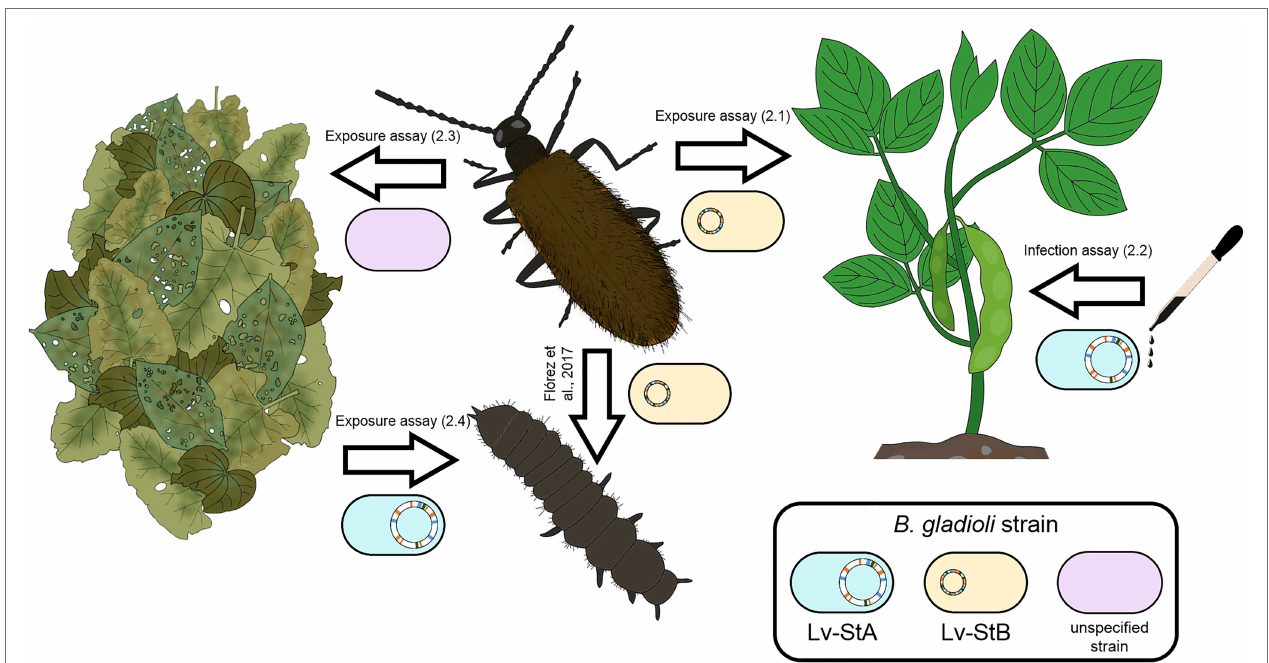
FIGURE 6 | Overview of demonstrated transmission routes in the L. villosa – Burkholderia symbiosis. The beetles can transmit the reduced-genome symbiont Lv-StB vertically, as well as horizontally to plants. In addition, they can transmit unidentified B. gladioli strain(s) to leaf litter. Lv-StA, the culturable strain without signs of genome erosion, is capable of infecting and surviving in different plant hosts and can be acquired from the leaf litter by the insect. The numbers in parenthesis indicate the section of the manuscript, or the published reference, in which evidence for each transmission route is